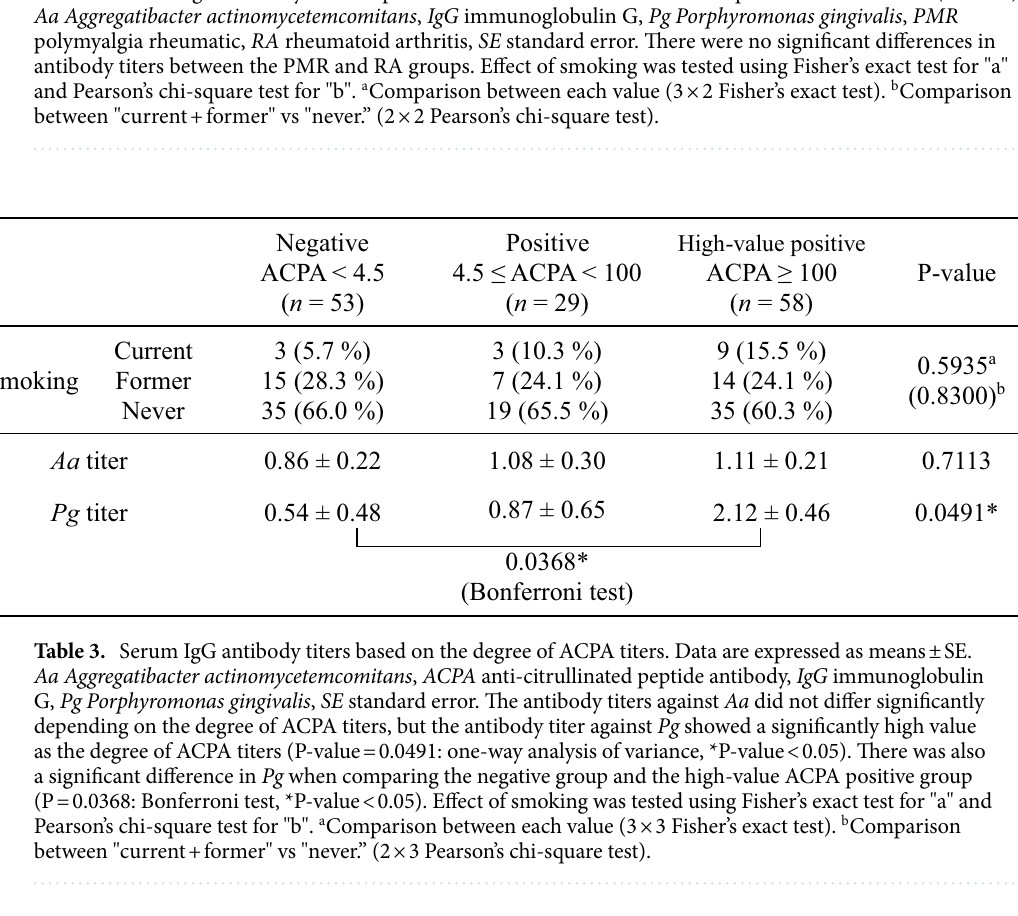
Table 3. Serum IgG antibody titers based on the degree of ACPA titers. Data are expressed as means ± SE. Aa Aggregatibacter actinomycetemcomitans , ACPA anti-citrullinated peptide antibody, IgG immunoglobulin G, Pg Porphyromonas gingivalis , SE standard error. The antibody titers against Aa did not differ significantly depending on the degree of ACPA titers, but the antibody titer against Pg showed a significantly high value as the degree of ACPA titers (P-value = 0.0491: one-way analysis of variance, *P-value < 0.05). There was also a significant difference in Pg when comparing the negative group and the high-value ACPA positive group (P = 0.0368: Bonferroni test, *P-value < 0.05). Effect of smoking was tested using Fisher’s exact test for "a" and Pearson’s chi-square test for "b". a Comparison between each value (3 × 3 Fisher’s exact test). b Comparison between "current + former" vs "never.” (2 × 3 Pearson’s chi-square test).